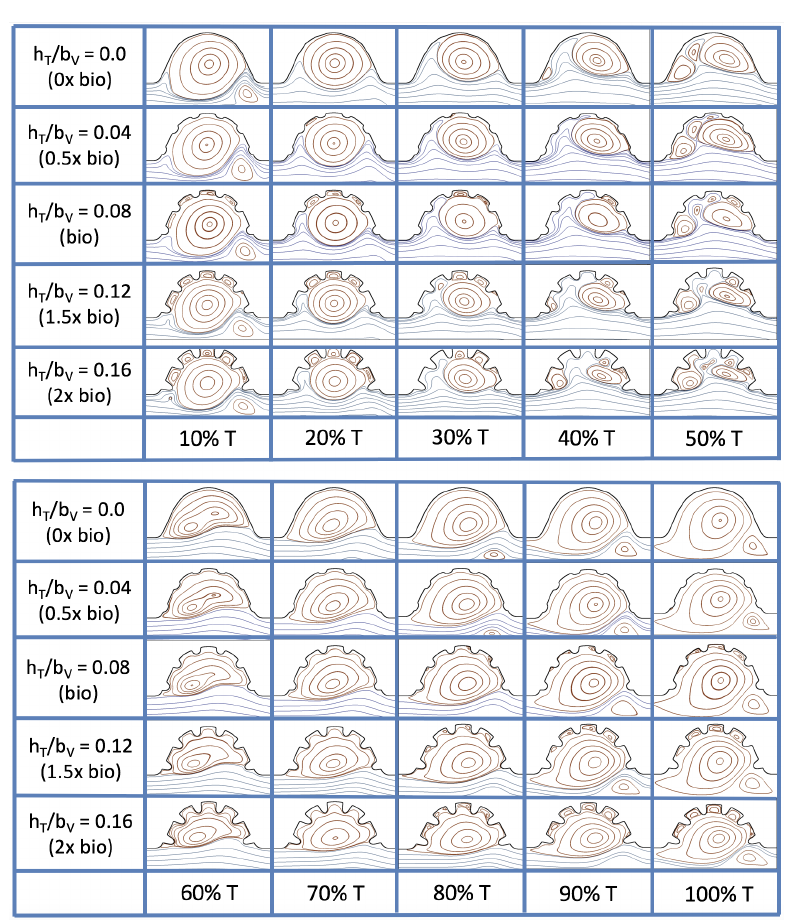
Figure 25. Streamline analysis performed for the case of pulsatile flow into the trabeculated ventricle of a zebrafish at 4 dpf for Re = 100 and varying trabeculae heights.